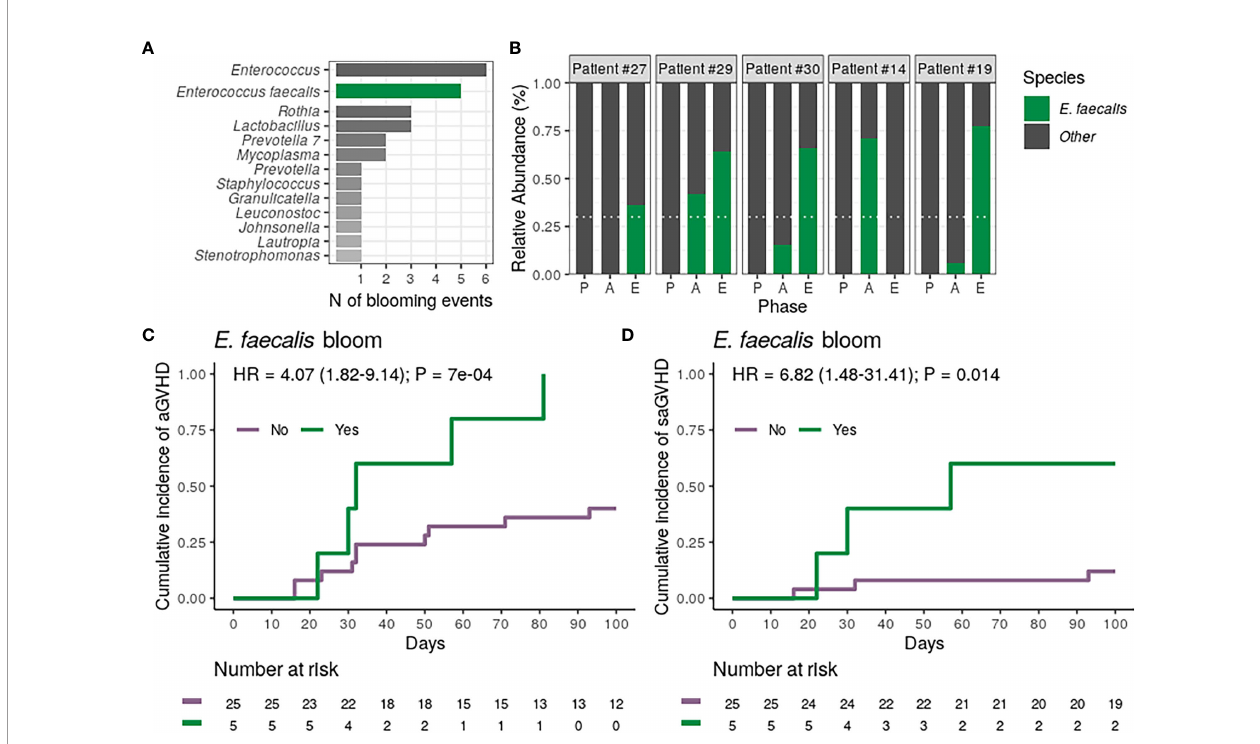
FIGURE 4 | Dental bio fi lm Enterococcus faecalis bloom during allogeneic hematopoietic stem cell transplantation is associated with a higher risk of acute graft- versus -host disease (aGVHD) and severe aGVHD (saGVHD). (A) Number of observed blooming events per genera in all patients (n = 30). The number of Enterococcus blooms caused exclusively by Enterococcus faecalis is indicated. (B) Relative abundance of Enterococcus faecalis across transplantation phases for all patients experiencing Enterococcus faecalis bloom (n = 5). Patients are sorted based on the highest Enterococcus faecalis relative abundance observed per patient. White horizontal dashed line indicates dominance threshold. P, Preconditioning; A, Aplasia; E, Engraftment. (C, D) Cumulative incidence of aGVHD (C) or saGVHD (D) with patients (n = 30) strati fi ed by Enterococcus faecalis bloom occurrence (No vs.